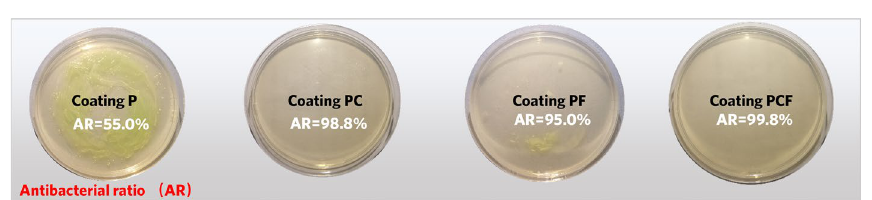
Figure 7. Antibacterial property of the coatings against a marine bacteria Pseudomonas